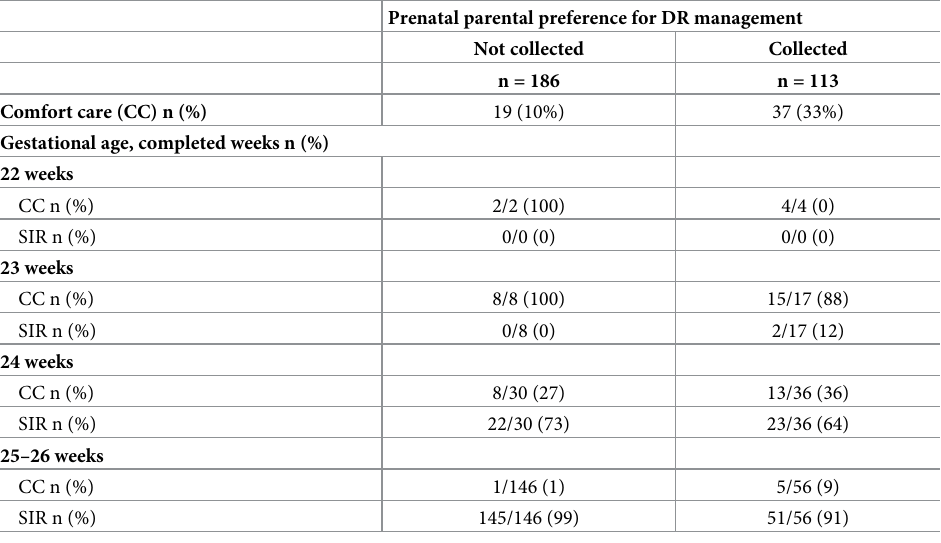
Table 2. Delivery room management according to gestational age and existence of prenatal parental preferences for delivery room